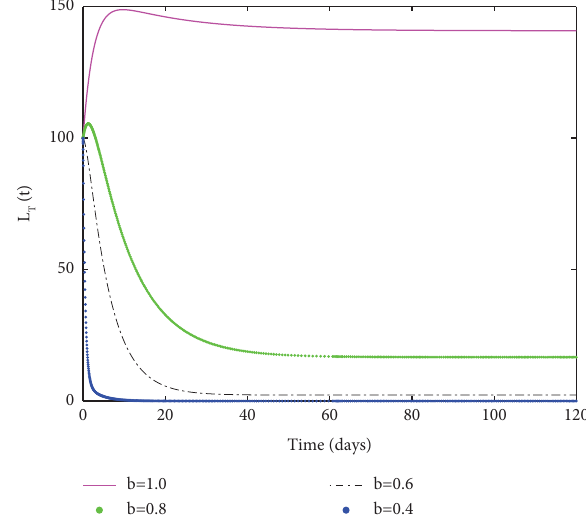
Figure 3: Behaviour of the latent TB infected individuals at diferent values of b .